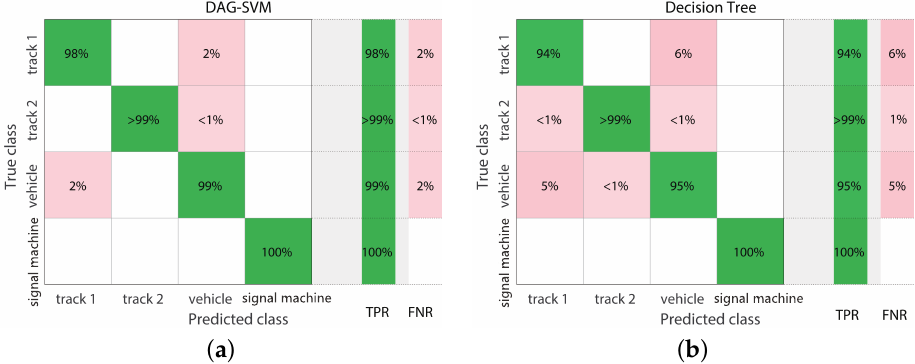
Figure 10. Confusion matrix of track recognition by DAG-SVM and decision tree at a radar height of